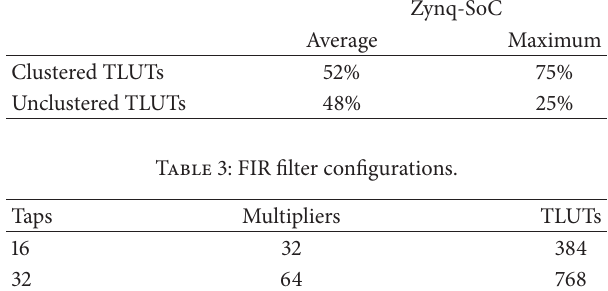
Figure 6: 𝑘 -tap, 8-bit FIR filter.